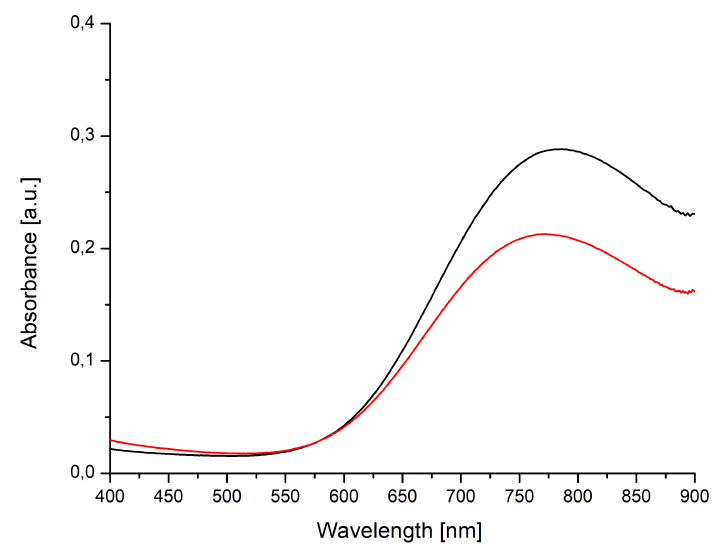
Figure 14. Vis spectra of 3b (black, c = 10 mmolL –1 ) and copper(II)-acetate (red, c = 1 mmolL –1